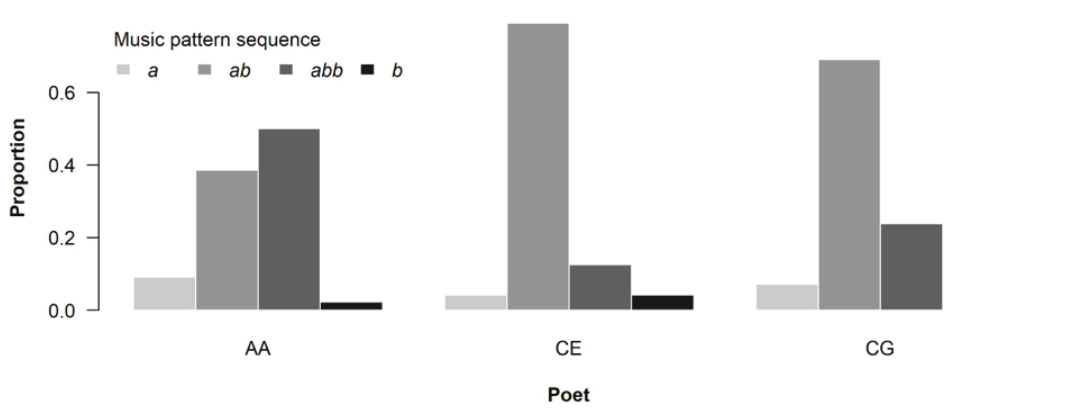
Figure 9: Overall counts of simple and compound melodic lines (including up to three MP's) per